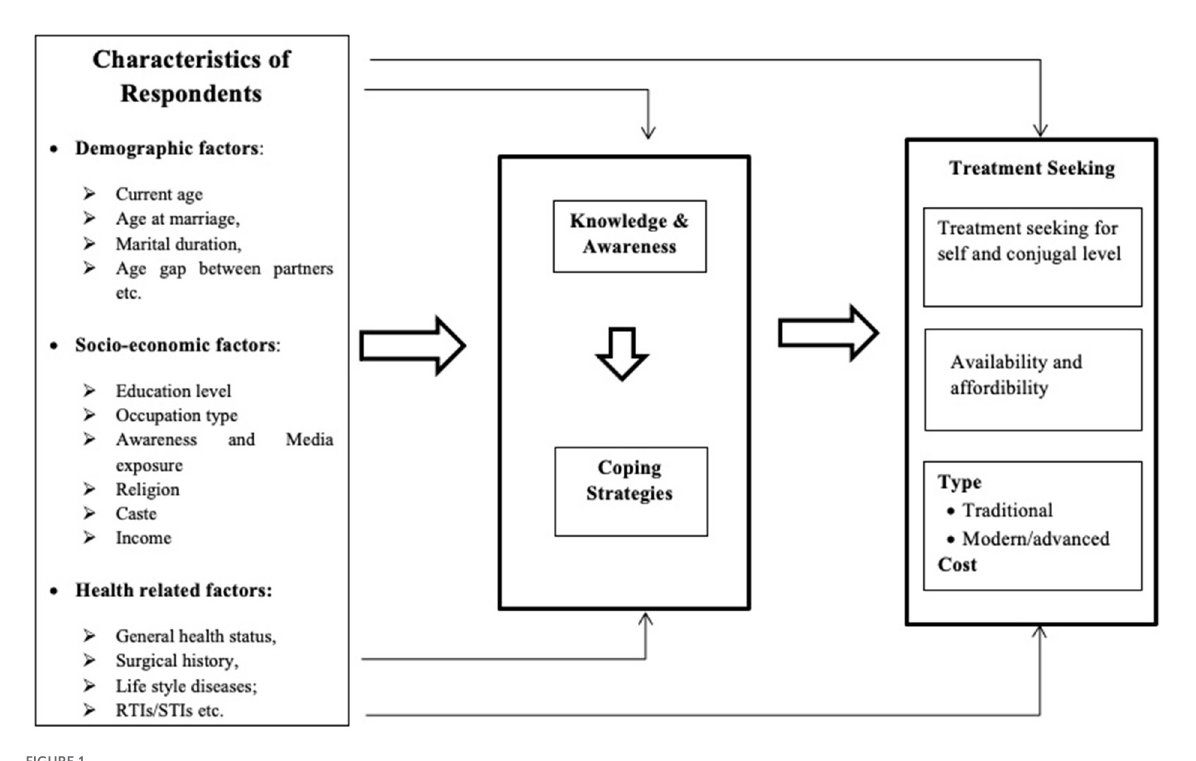
FIGURE1 Conceptual